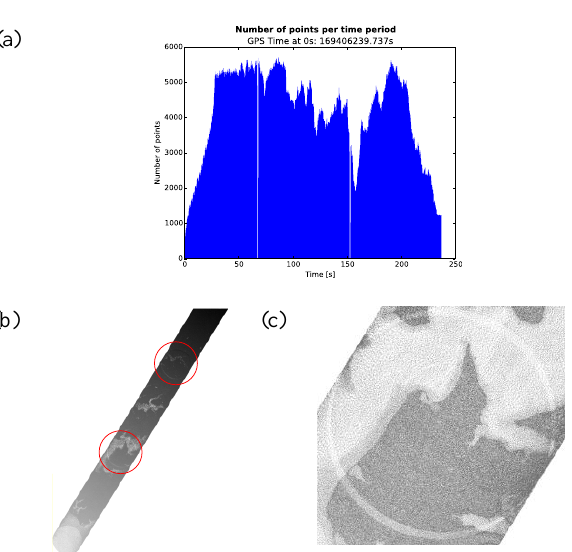
Figure 8. Circular artefacts: (a) apparent momentary dropouts in Leica SPL100 data recording; (b) resultant artefacts in one swath; (c) close-up of one artefact showing resultant impact on point